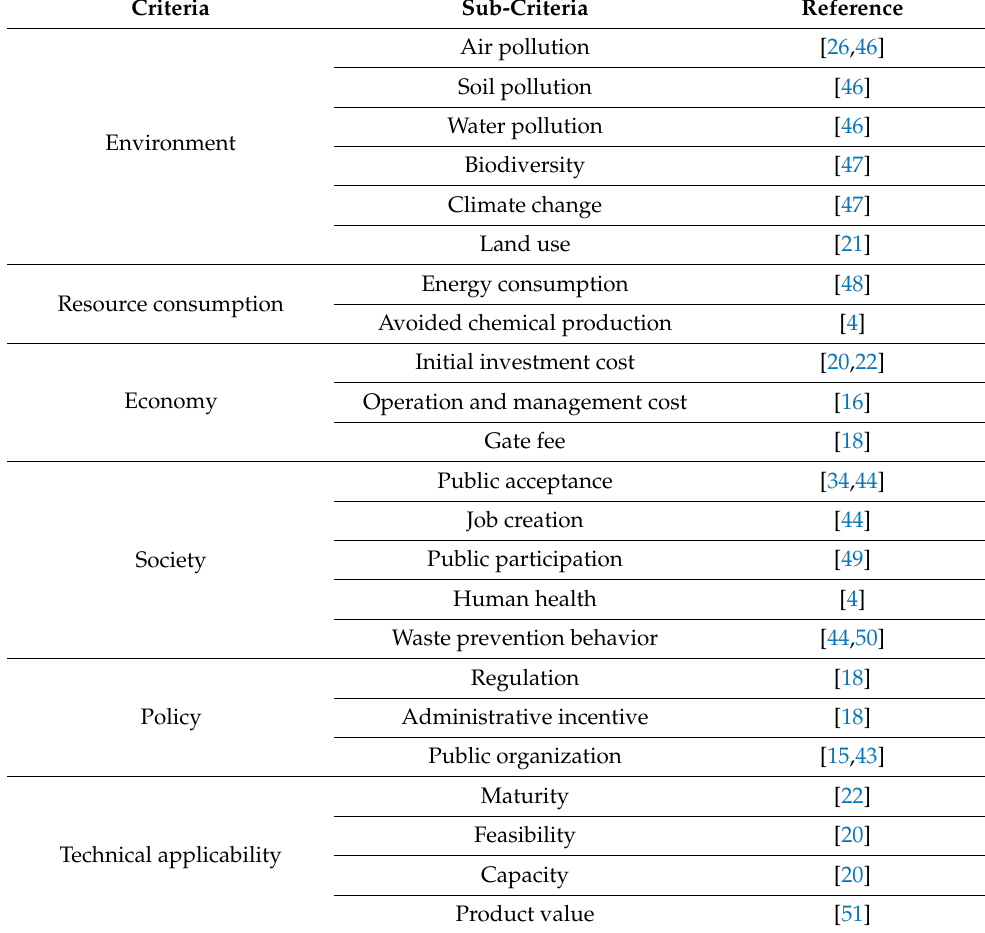
Table 1. Criteria and sub-criteria